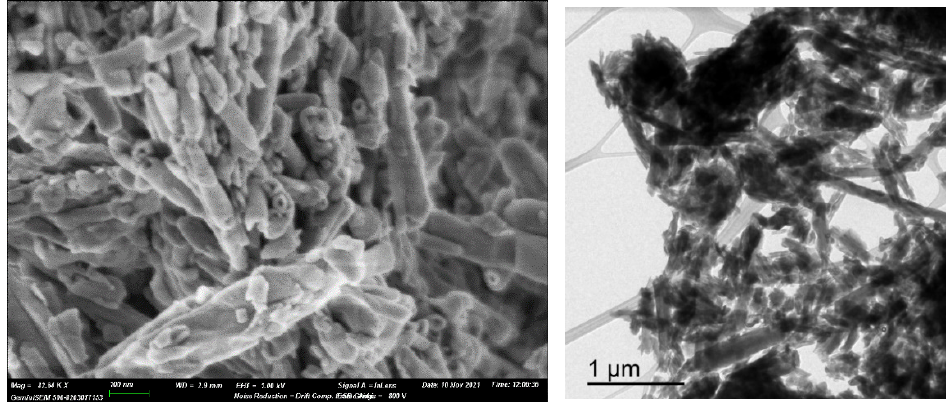
Figure 5. Halloysite SEM ( left ) and TEM ( right ) images.